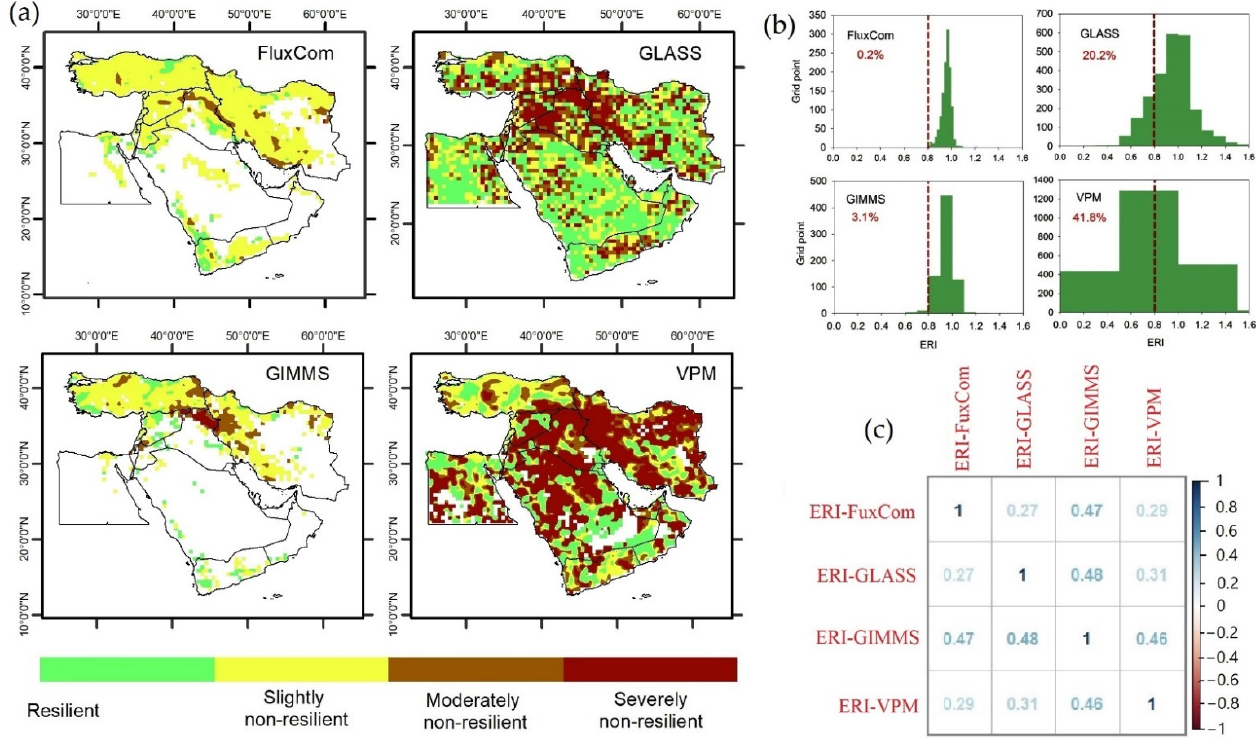
Figure 9. ( a , b ) Spatial distribution of ERIs in the Middle East during 1982–2016 as suggested when using the different GPP products. ( c ) Cross-correlation values among the calculated ERIs of several GPP